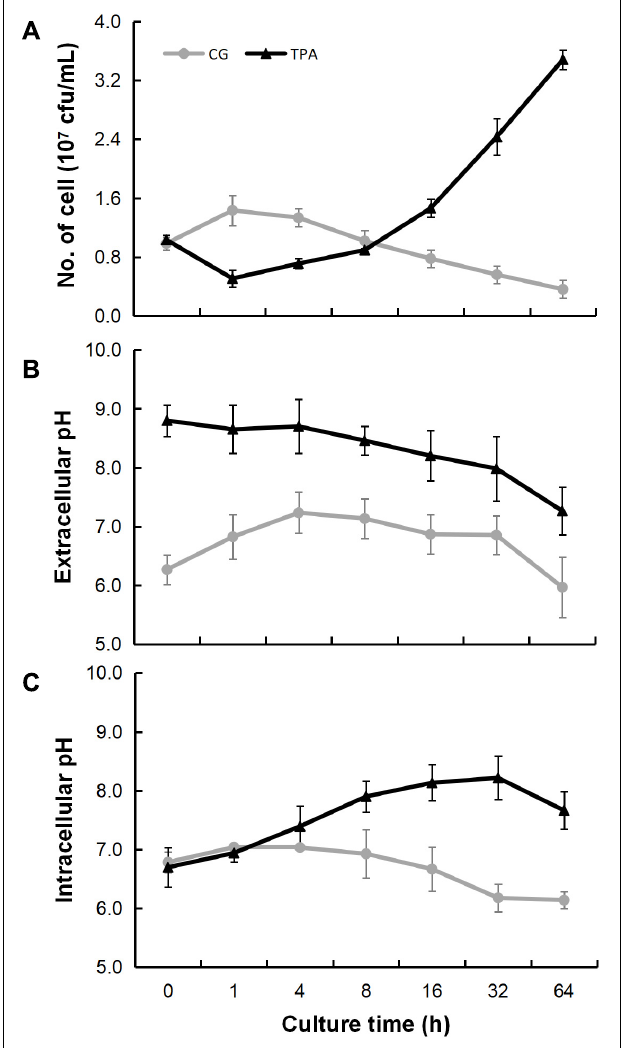
FIGURE 3 | Bacteriostatic ability, extracellular pH, and intracellular pH of B. trispora after treatment with TPA. After the strains were fermented for 2 days, the bacteriostatic ability (A) , extracellular pH (B) , and intracellular pH (C) were measured after TPA treated for 0, 1, 4, 8, 16, 32, and 64 h. TPA, tripropylamine treated group; CG, control